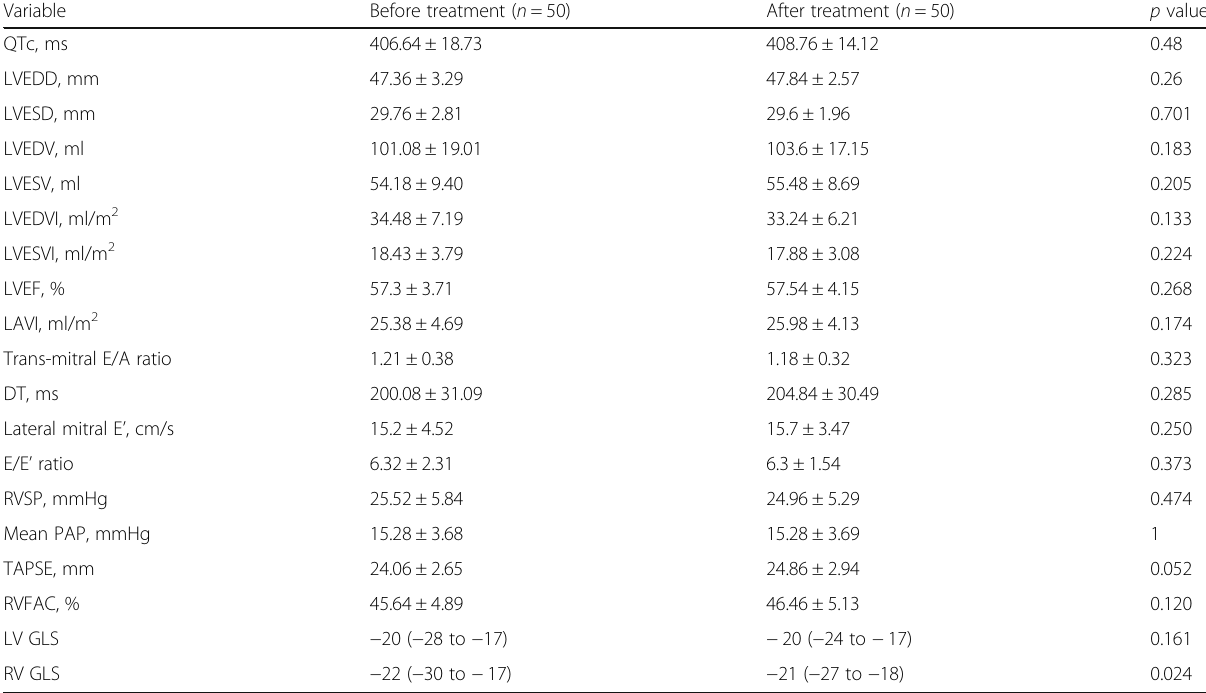
Table 2 Comparing ECG and echocardiographic variables in patients with no liver cirrhosis before and after treatment